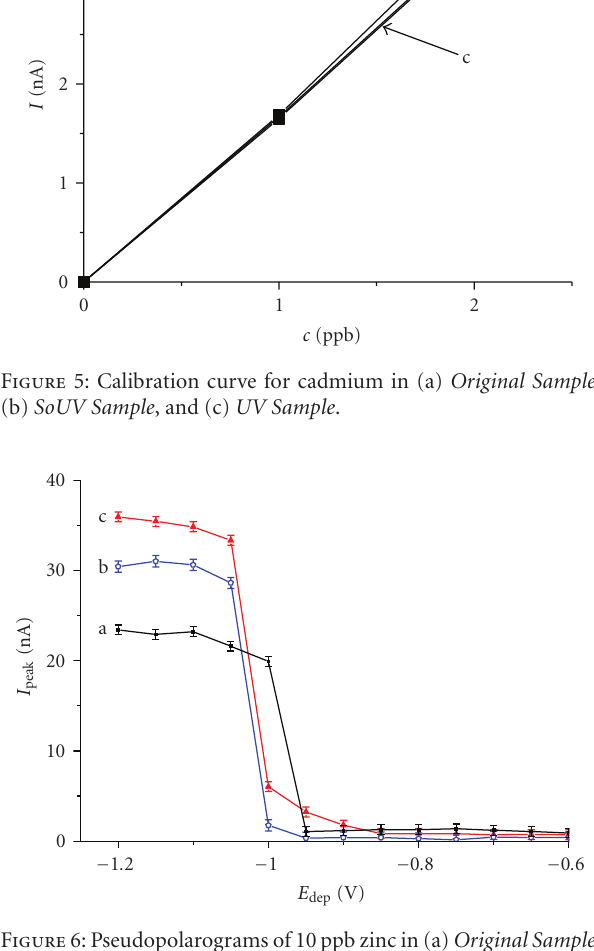
Figure 6: Pseudopolarograms of 10ppb zinc in (a) Original Sample , (b) SoUV Sample, and (c) UV Sample ; DPASV at HMDE, accumula- tion time 240 s, initial potential − 1.2 V, final potential − 0.70 V, scan increment 0.05 V, interval time 0.5 s, scan rate 10mV/s, and 0.1 M acetate bu ff er containing 0.1 M KCl (pH =